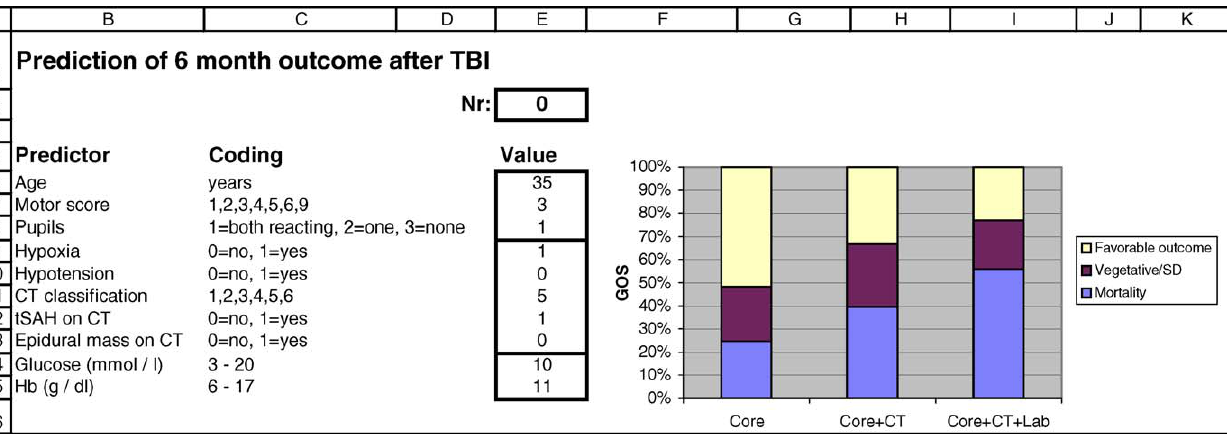
Figure 3. Screenshot of the Spreadsheet with Calculations of Probabilities for the Three Prediction Models Predictions are calculated for a 35-y-old patient with motor score 3, both pupils reacting, hypoxia before admission, mass lesion and tSAH on admission CT scan, glucose 11 mmol/l, and Hb 10 g/dl. A Web-based calculator is available at